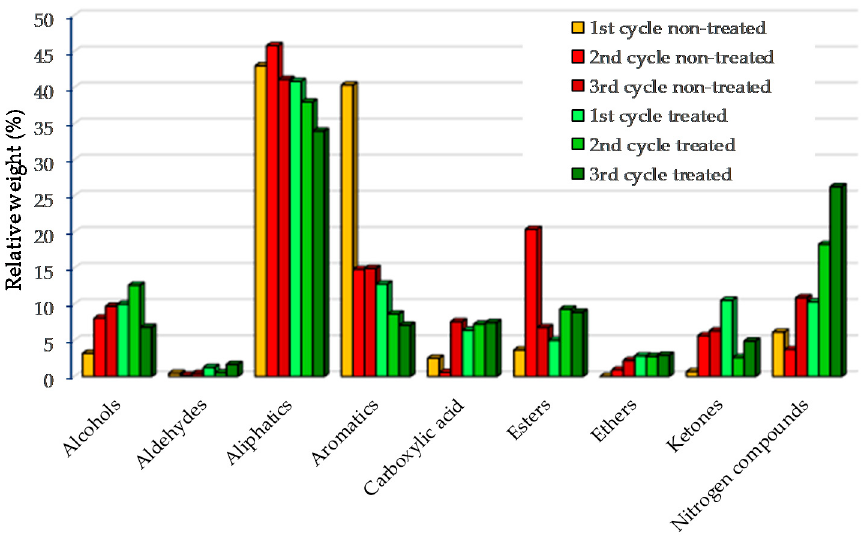
Figure 3. GC-MS bio-oil based on groups for catalyst regeneration of treated and non-treated microalgae.